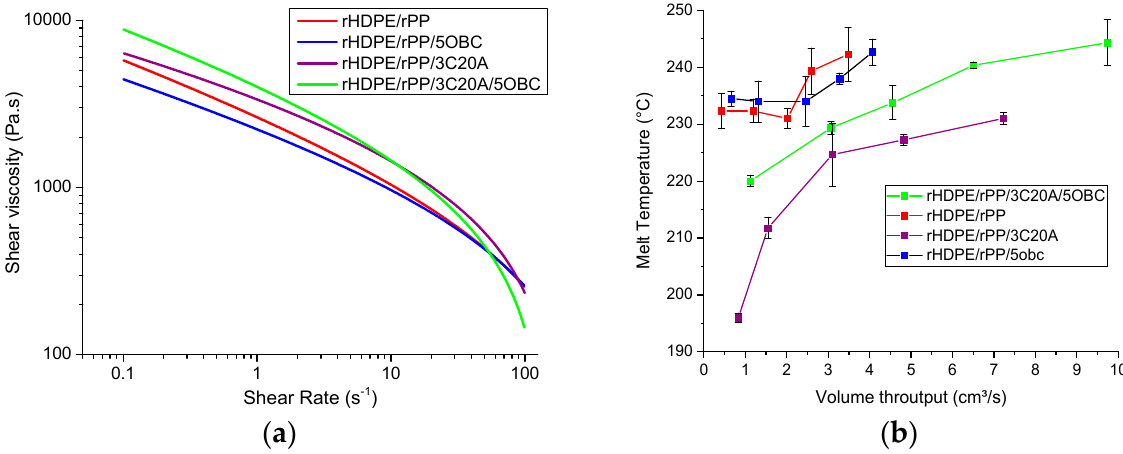
Figure 9. Shear viscosity measured using a plate-plate rheometer at 180 °C ( a ) and melt temperature as a function of volume throughput ( b ).